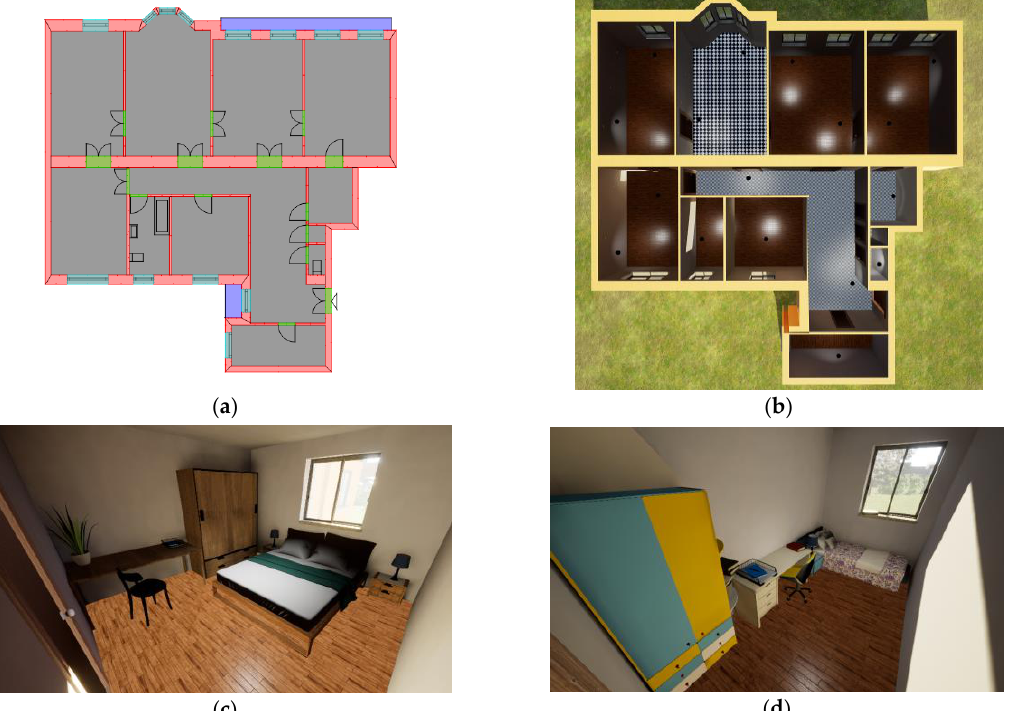
Figure 16. ( a ) The result of the symbol detection process. ( b ) The final environment for VR. ( c ) and ( d ) Manually furnished rooms for the user study.